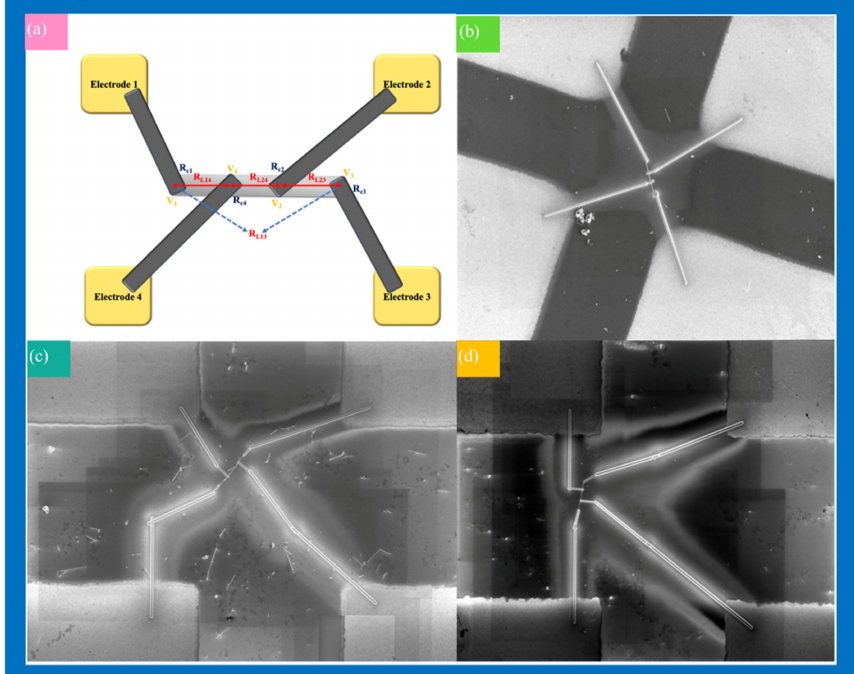
Figure 8. ( a ) Schematic illustration of the electrical measurement setup. SEM images of the measured ( b ) ITO NW, ( c ) 1 at% Ag-ITO NW, ( d ) 3 at% Ag-ITO NW, connected to four metal